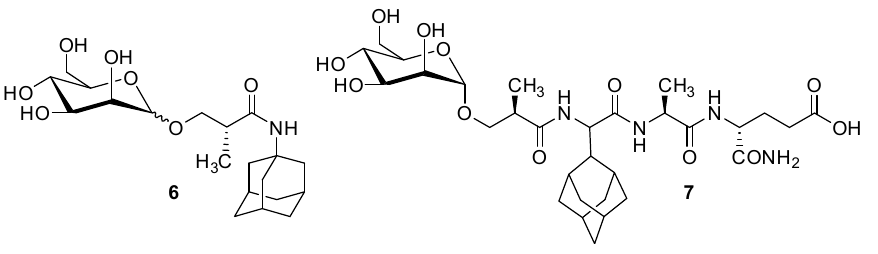
Figure 2. Structures of mannosylated 1-aminoadamantane ( 6 ) and mannosylated (adaman-2-yl)- tripeptide ( 7 ).